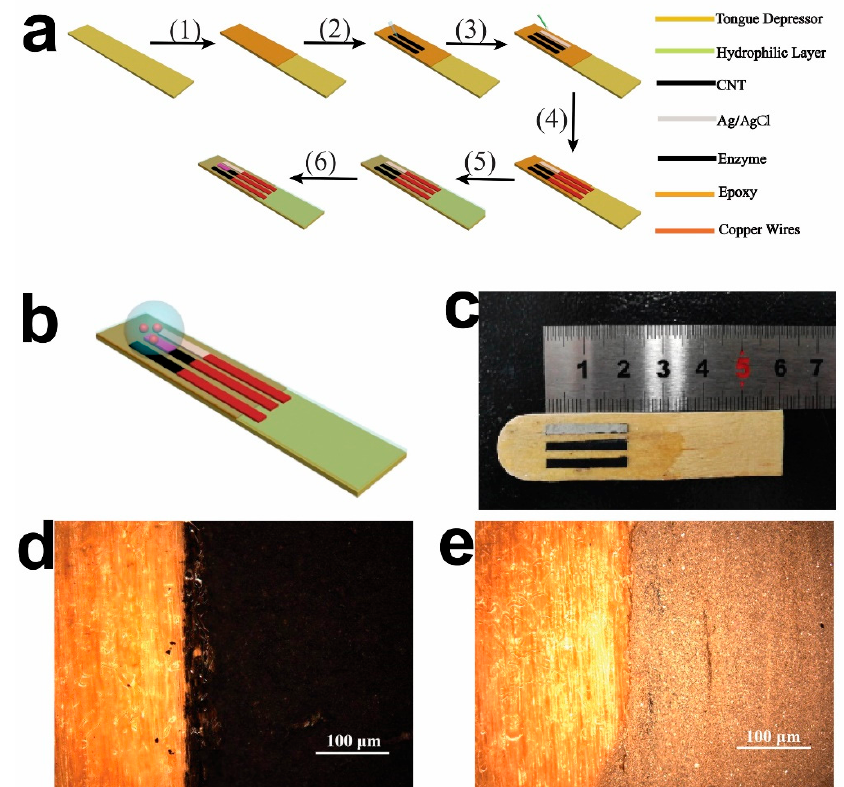
Figure 1. Images of the tongue depressor based amperometric sensor. ( a ) A schematic illustration